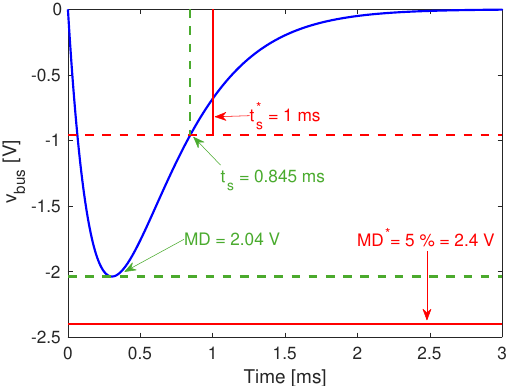
Figure 9. Theoretical simulation of the normalized voltage